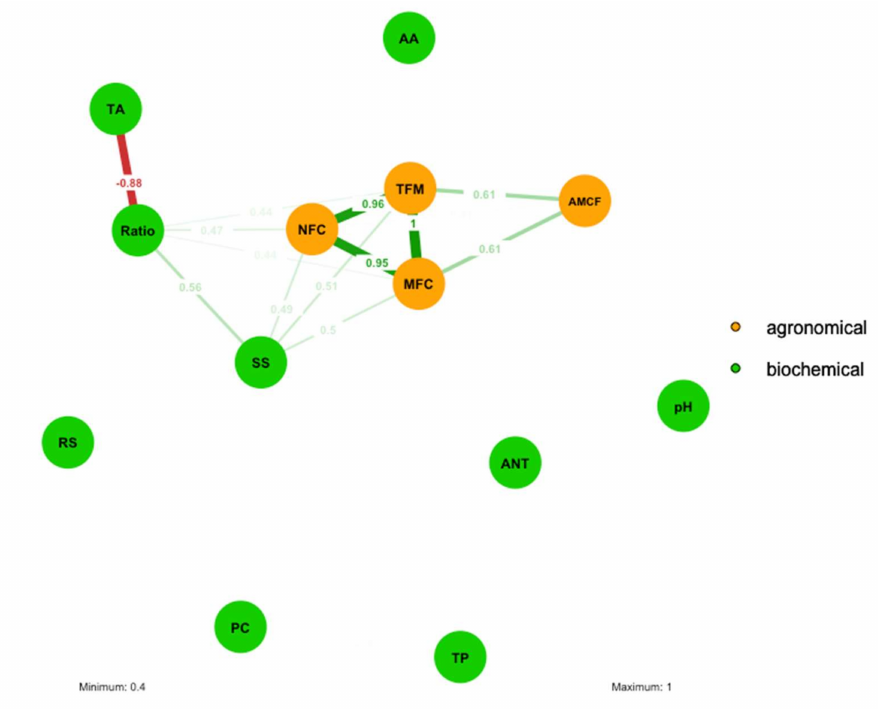
Figure 4. Correlation analysis between agronomic, physicochemical, and bioactive compound traits obtained from di ff erent Fragaria × ananassa Duschesne ex Roziergenotypes.NCF: Number of Commercial Fruits (fruits / plant), AMCF: Average Mass of Commercial Fruits (g / fruit), MCF: Mass of Commercial Fruits (g / plant), TFM: Total Fruit Mass (g / plant), SS: Soluble Solids (Brix), TA: Titratable acidity (g citric acid 100 g − 1 pulp), SS / TA Ratio: Soluble Solids / Titratable Acidity, RS: Reducing Sugar (%), PC: Phenolic Compounds (mg galic acid 100 g − 1 pulp), TP: Total Pectin (g total pectin 100 g − 1 pulp), AA: Ascorbic Acid (mg ascorbic acid 100 g − 1 pulp), and ANT: Anthocyanins (mg pelargonidin-3-glycoside 100 g − 1